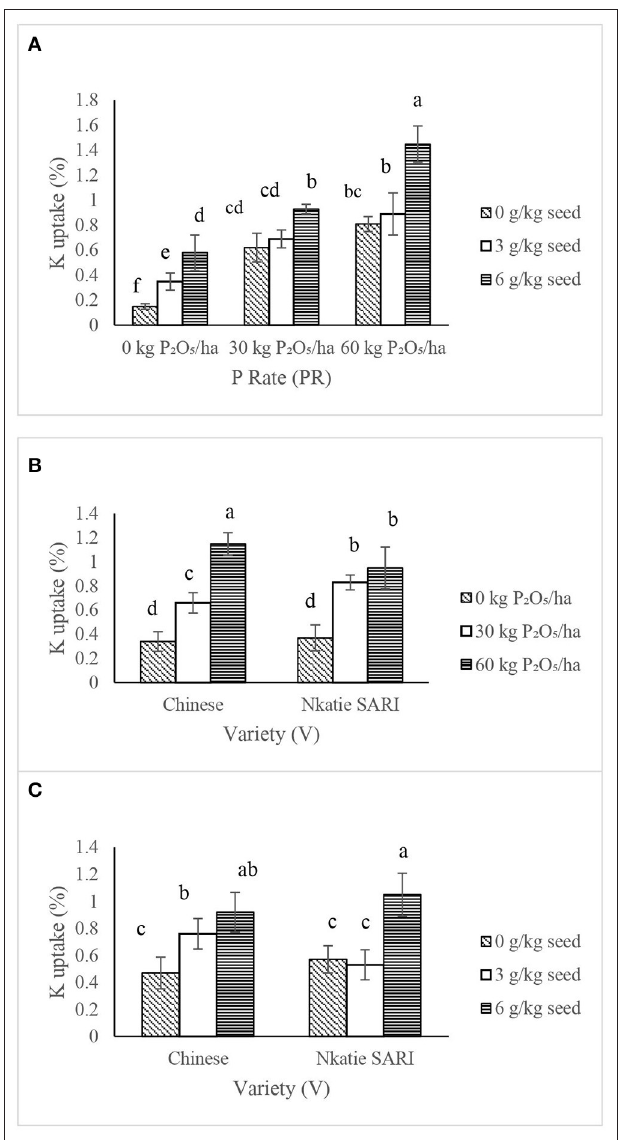
FIGURE 10 | Interactive effect of effects of P-rate (PR) and inoculant rate (IR) (A) ; P-rate (PR) and variety (V) (B) ; and inoculant rate (IR) and variety (V) (C) on K uptake of groundnut in Haplic Lixisols of northern Ghana. Bars with different letters (in horizontal direction) show significantly different means. Error bars represent standard error of